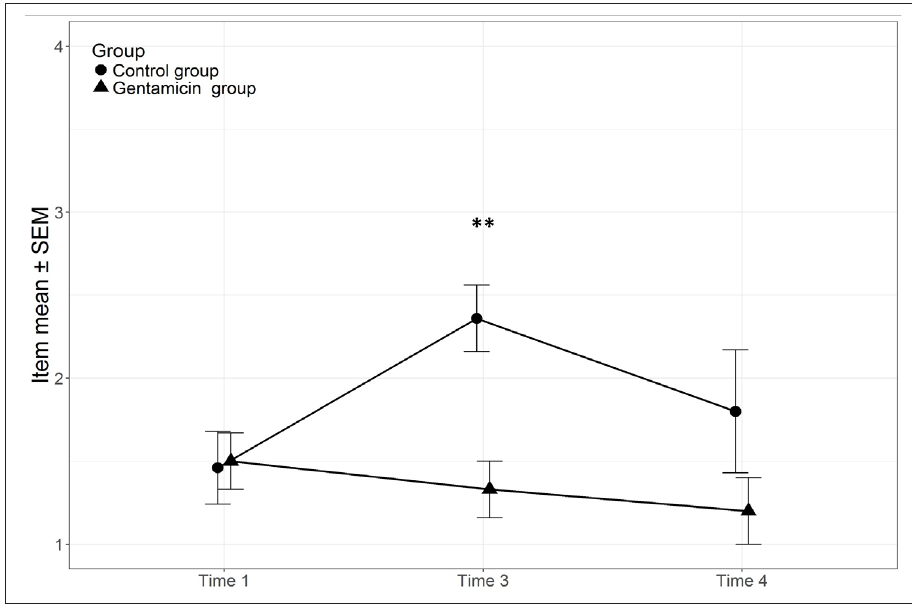
Fig. 4. Means and SEM for question 3: Do you have instability with, or does quickly changing position bother you (e.g. lying on a bed / getting up / recumbent)?